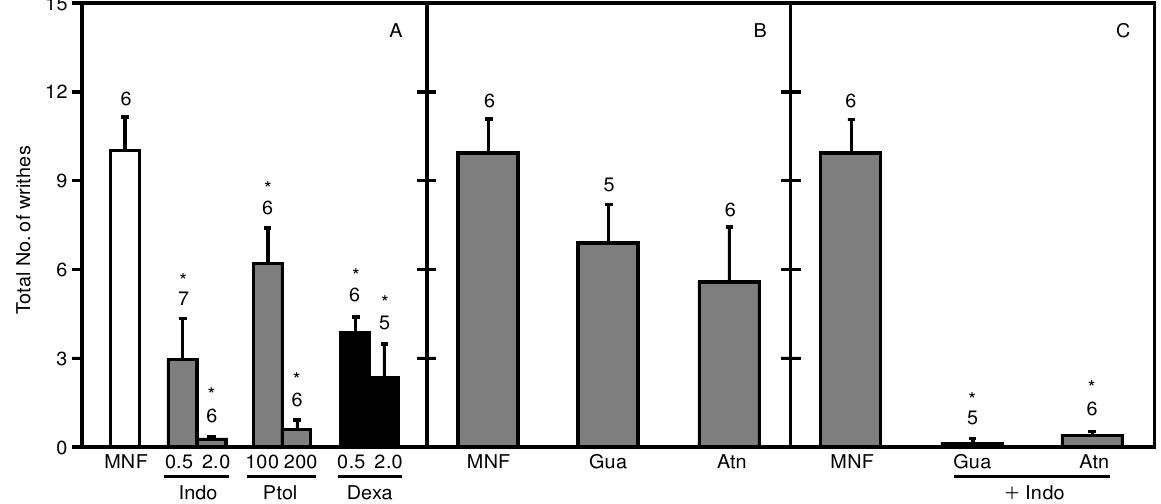
FIG. 3. Effects of indomethacin, paracetamol, dexamethasone, guanethidine and atenolol on MNF-induced writhing in mice. (A) Number of writhes induced by MNF in untreated mice (MNF, i.p., 0 · 1 ml / g body weight) and in mice pretreated s.c. with the indicated doses (mg / body weight) of indomethacin (Indo, 30 min before), paracetamol (Ptol, 30 min before) or dexamethasone (Dexa, 60 min before) (B) Number of writhes induced by MNF in untreated mice (MNF, i.p., 0 · 1 ml / g body weight) and in mice pretreated by s.c. injection of guanethidine (Gua, 30 mg / kg) or atenolol (Atn, 0 · 5 mg / kg) 30 min before injection of the nociceptive stimulus (MNF). (C) Number of writhes induced by MNF in untreated mice (MNF, i.p., 0 · 1 ml / g body weight) and in mice pretreated by s.c. injection of the association of guanethidine (Gua, 30 mg / kg) and indomethacin (Indo, 0 · 5 mg / kg) and atenolol (Atn, 0 · 5 mg / kg) 30 min before the injection of the nociceptive stimulus (MNF). The values are reported as means SEM of the total number of writhes occurring between 14 and 34 min after challenge with MNF. The number at the top of each bar represents the number of mice in that group. , Statistically signi® cant differences (P , 0 · 05) from the control group determined by ANOVA and Bonferroni’s test.